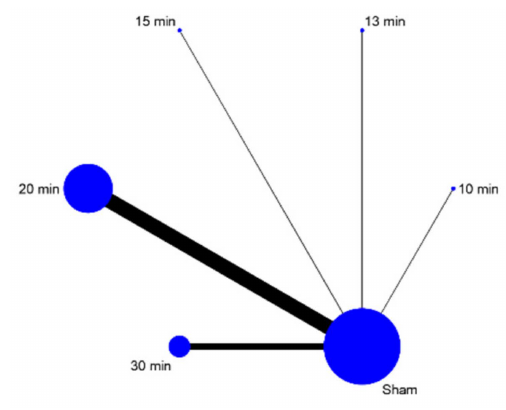
Figure 8. Network map session